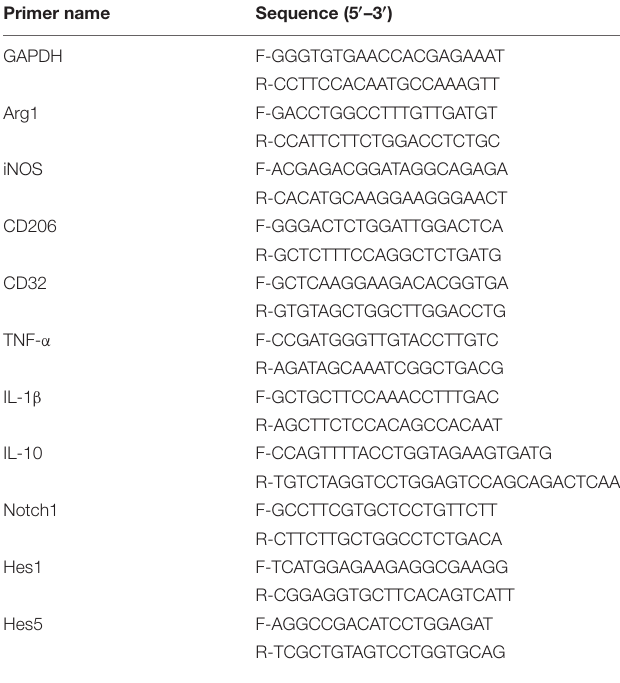
TABLE 1 | Primers used for